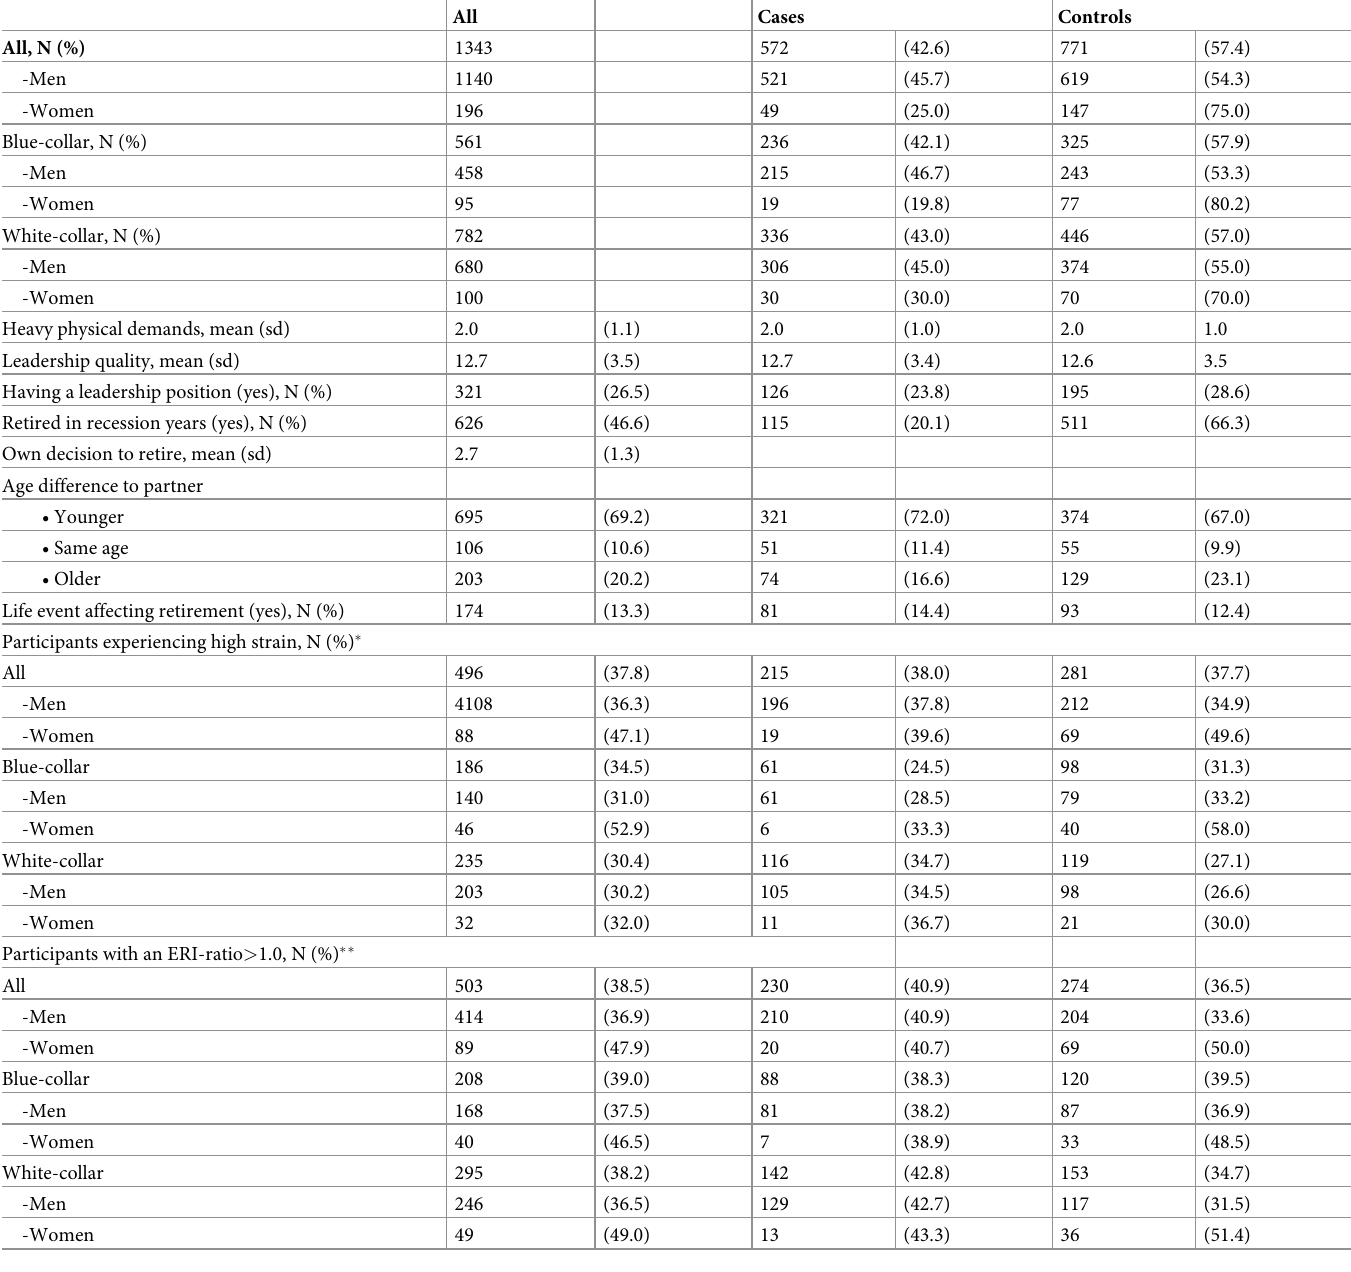
Table 1. Cohort characteristics according to demographics and psychosocial variables.